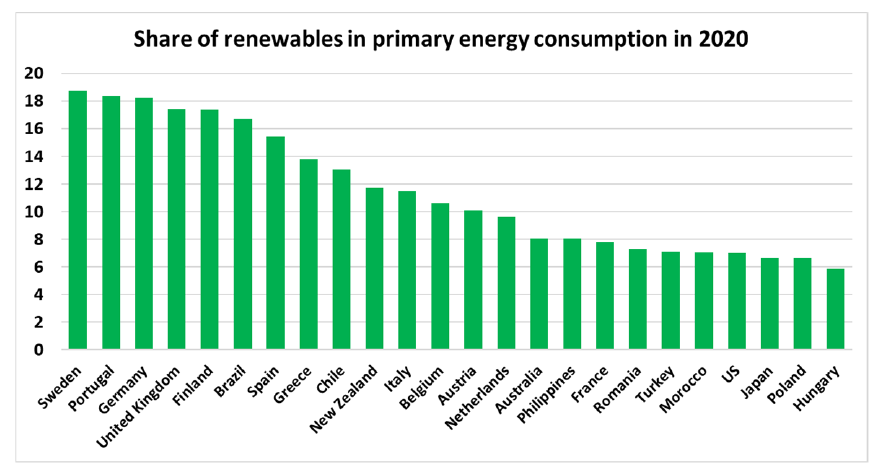
Figure 4. Countries in which the shares of renewables in primary energy consumption are the largest in 2020, % [5].